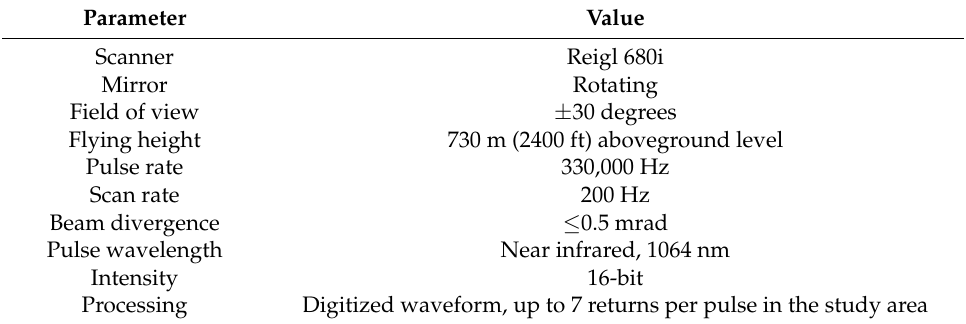
Table 1. 2015 light detection and ranging (LiDAR) acquisition